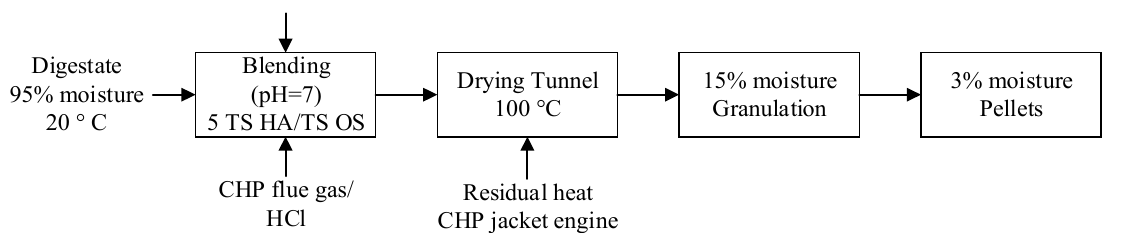
Figure 7. Proposed process A for the manufacturing of a granular fertilizer. (CHP = Combined heat and power plant) to be implemented at the headquarter of a 40,000 tonnes/year production facility of anaerobic digestate with a CHP unit for valorization of the biogas. Optimum blending ratio was defined as 5 TS HA/TS OS [31].